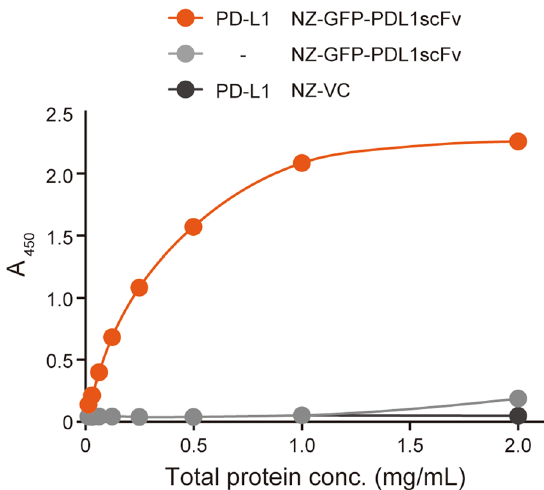
Fig. 3 Immunoreactivity assay of NZ-GFP-PDL1scFv against PD-L1. A binding assay using an anti-His tag antibody was performed to verify the immunoreactivity of rGFP-PDL1scFv. Serially diluted cellular extracts of each gmLAB were added to wells immobilized (orange and black line) or not immobilized (gray line) with PD-L1 protein. The bound scFv was detected using an anti-His tag antibody, and the absorbance at 450 nm was measured. The data are representative of two independent experiments. Orange line: PD-L1 , NZ-GFP-PDL1scFv, Gray line: PD-L1-, NZ-GFP-PDL1scFv, Black + line: PD-L1